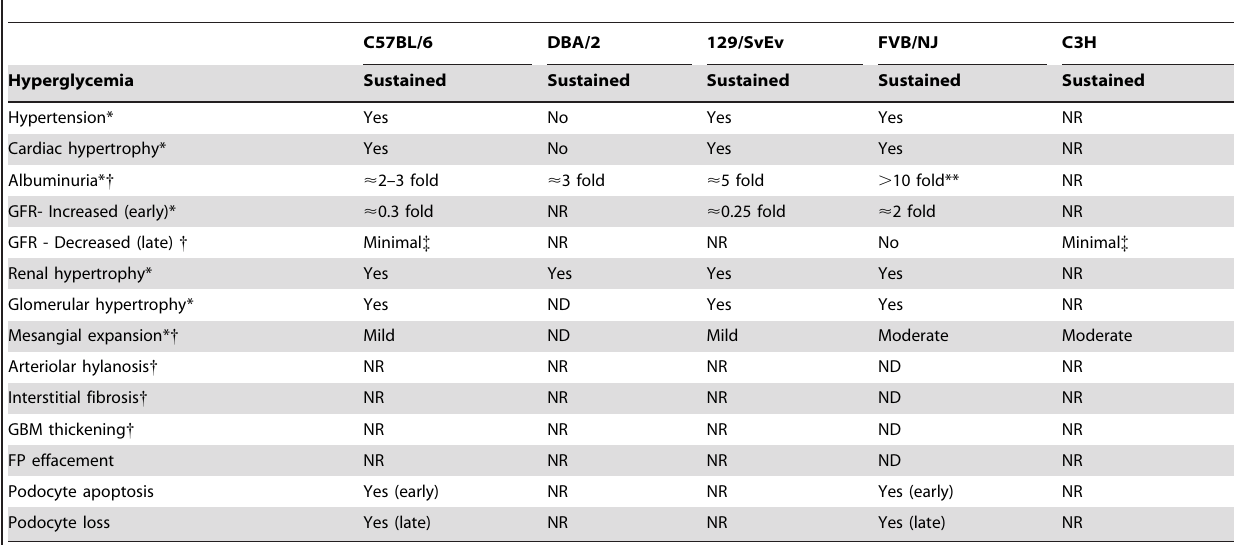
Table 6. Renal phenotype of male Akita mice by genetic